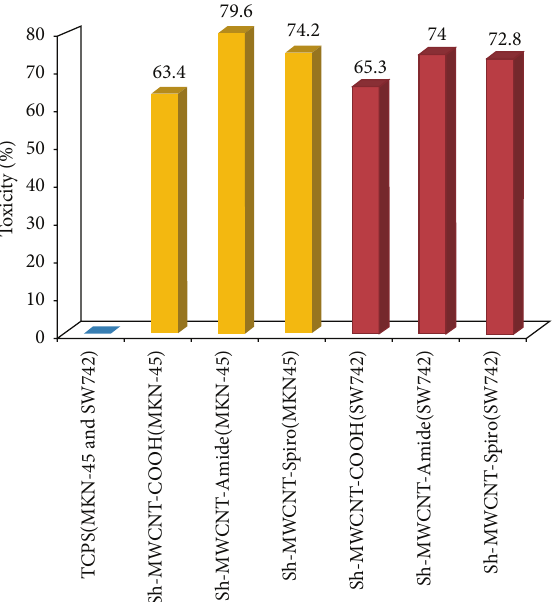
Figure 8: MTT assay for TCPS and modified MWCNTs after 48